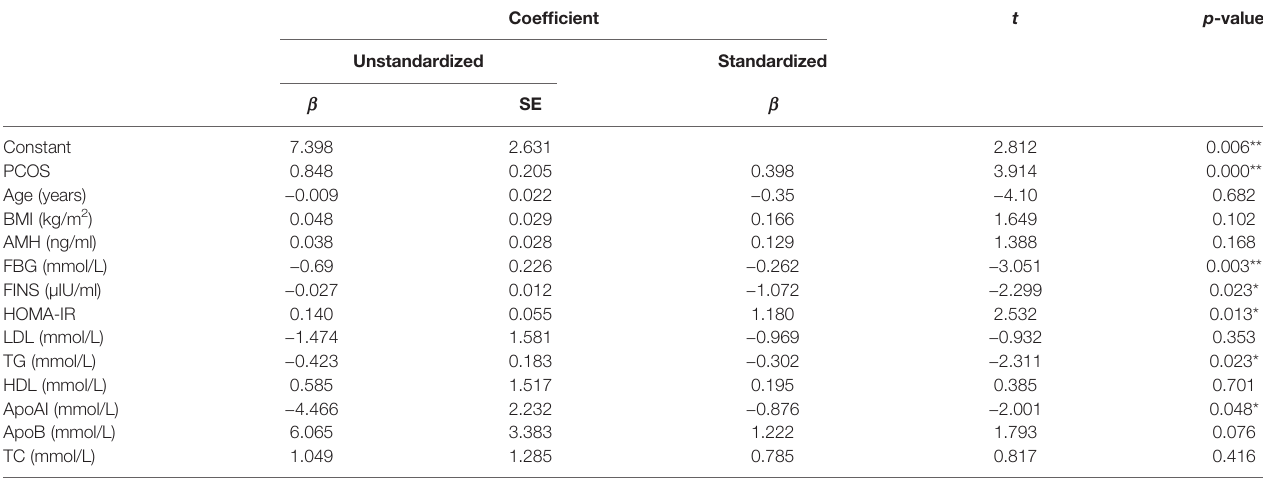
TABLE 3 | Multiple linear regression analysis of ANGPTL4 relative